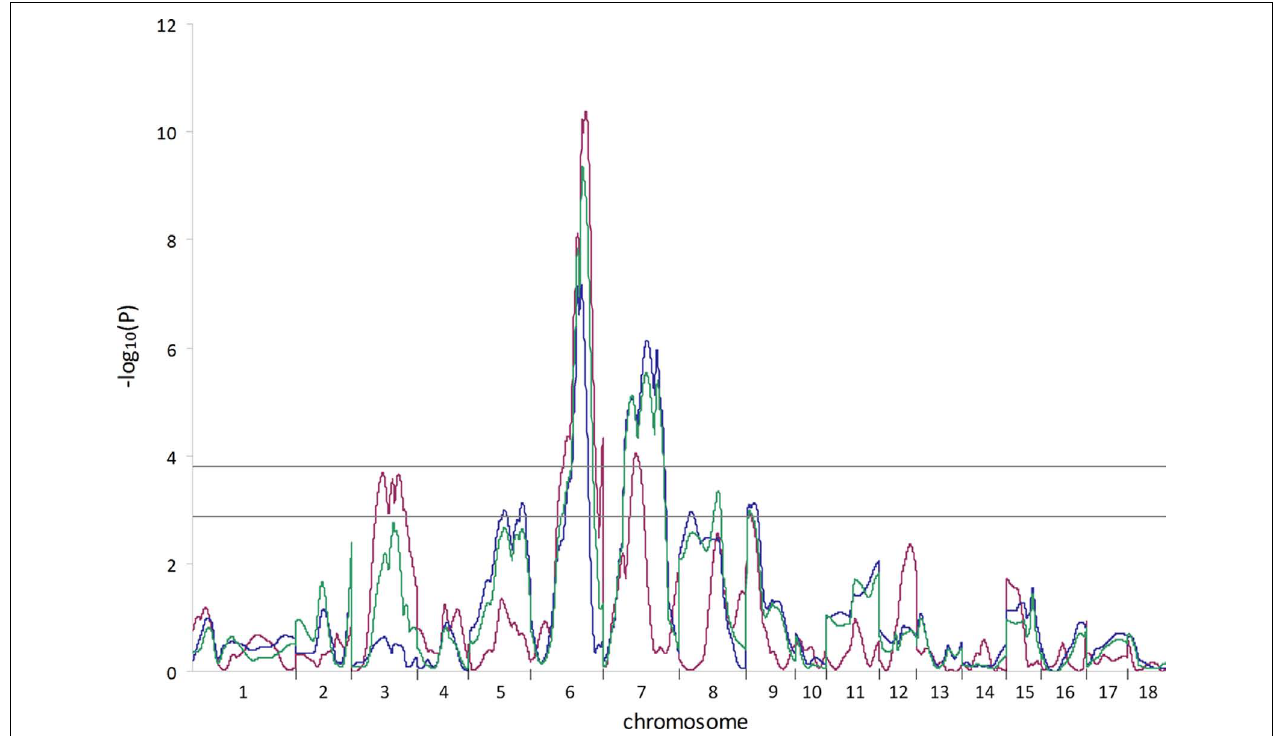
FIGURE 1 | Genome scan results for ham weight determined using different analysis models. A whole genome scan to identify QTL for the trait ham weight was performed using three different analysis models (line-cross,